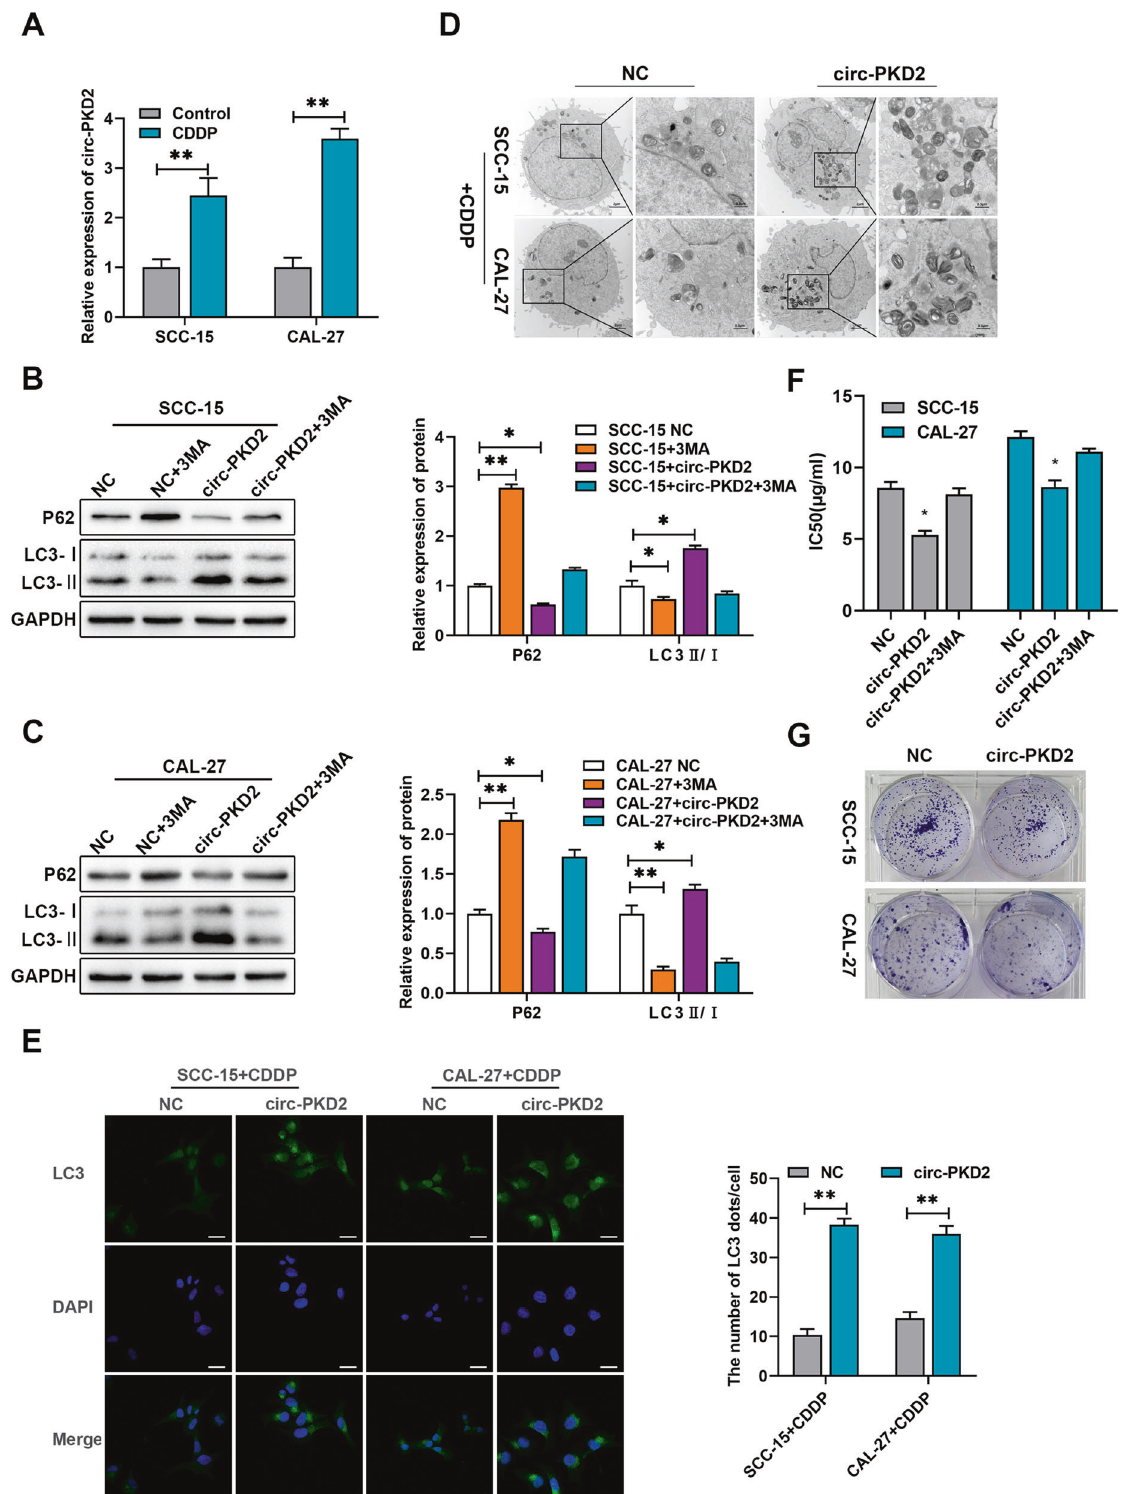
circ-PKD2 greatly increased autophagy, evidenced by the increased LC3-II to LC3-I ratio and the attenuated p62 protein level (Fig. 2B, C). Based on TEM, the overexpression of circ-PKD2 promoted the accumulation of autophagic vesicles in SCC-15 and CAL-27 cisplatin-treated cells (Fig. 2D). The immuno fl uor- escence assay con fi rmed that cells transfected with circ-PKD2 Cell Death and Disease (2022)